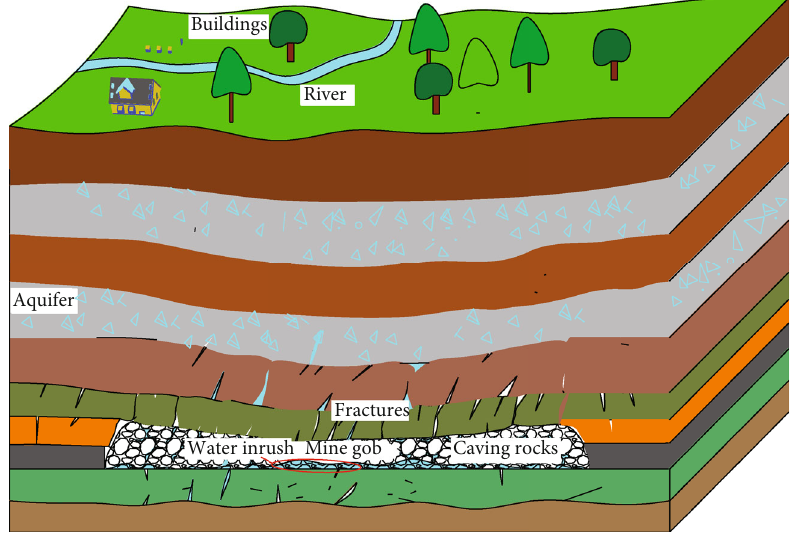
Figure 6: Water inrush in a coal mine induced by an aquifer.